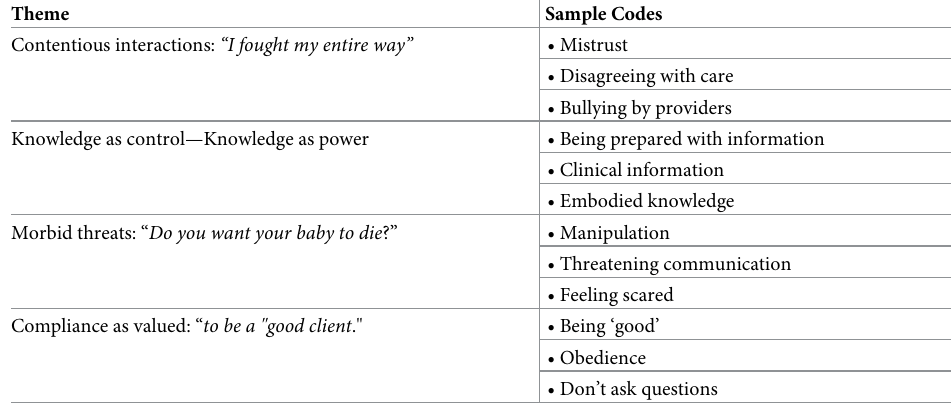
Table 1. Themes and excerpted